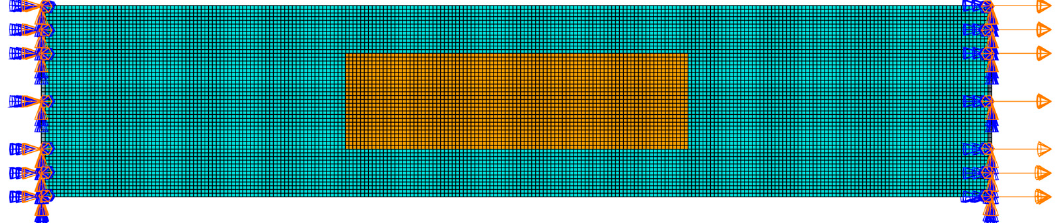
Figure 7. Boundary conditions and displacement load of structural analysis model.